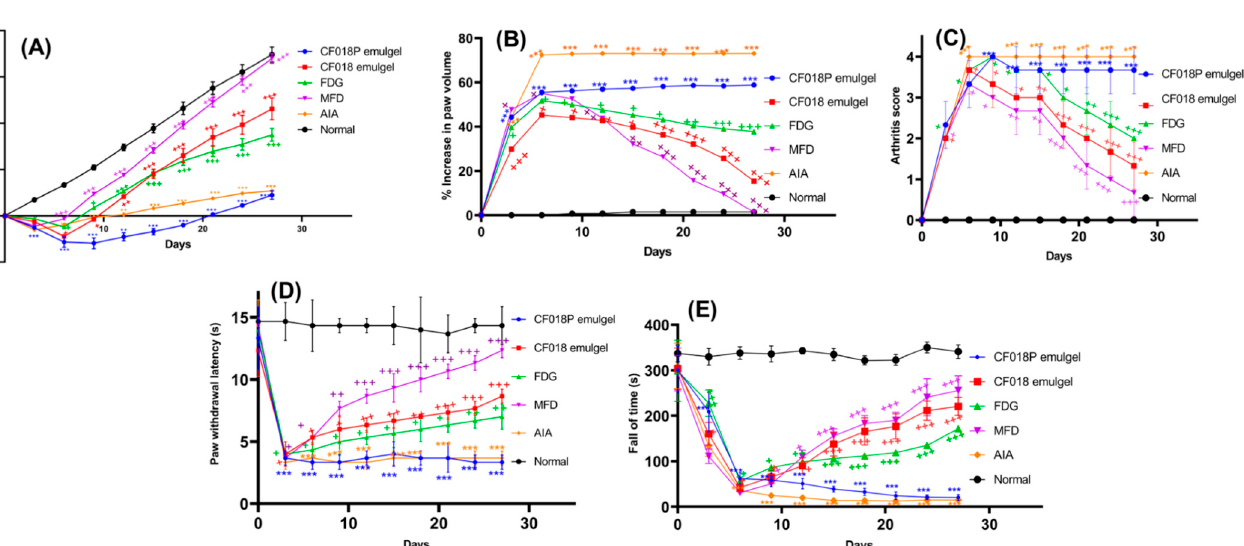
Figure 12. Histopathology of skin sample after skin irritation studies. ( A ) Group I—untreated group. ( B ) Group II—FDG (200 mg from 0.05% gel). ( C ) Group III—CF018 emulgel (200 mg from 0.05% gel). ( D ) Group IV—CF018P emulgel (200 mg from 0.05% gel). ( E ) Group V—received 5% SLS gel [Note ( → ) Indicates hyperkeratosis ( → ) Necrosis].